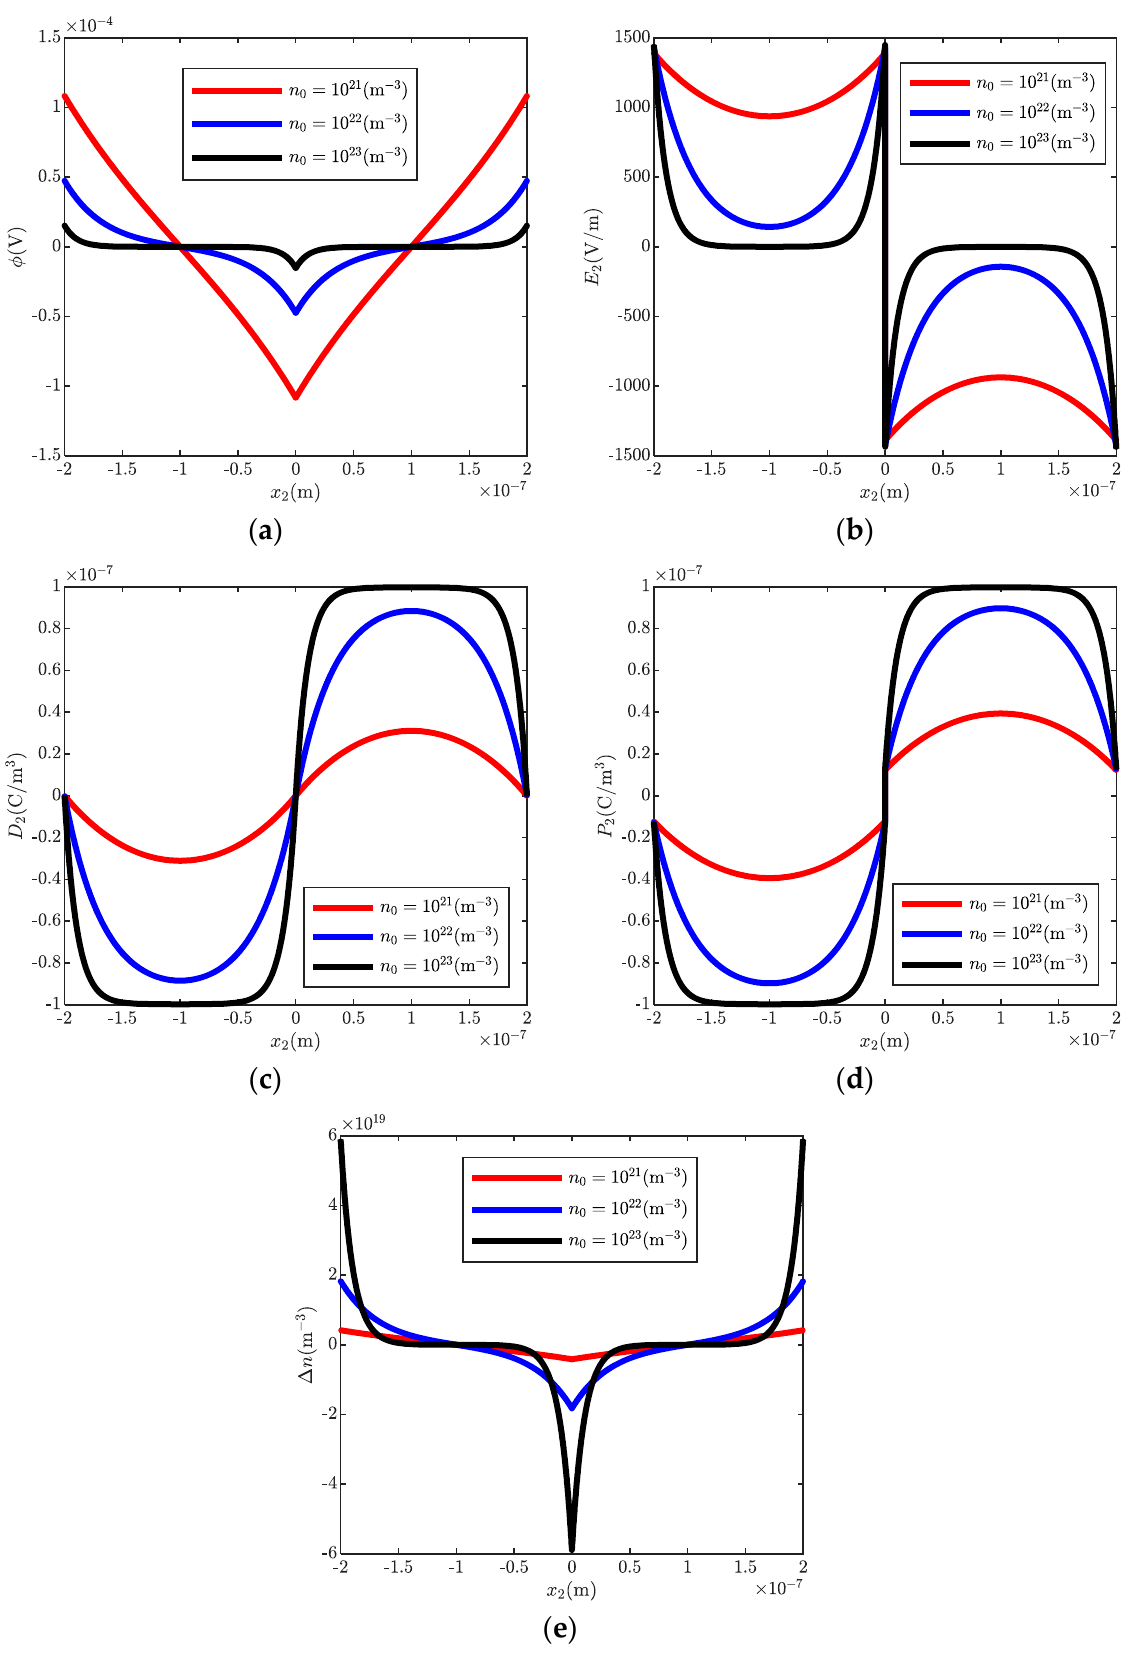
Figure 3. Electrostatics in a ZnO bi-layer with different doping concentrations. ( a ) electric potential φ E , ( c ) electric displacement , ( b ) electric field 2 n Δ .